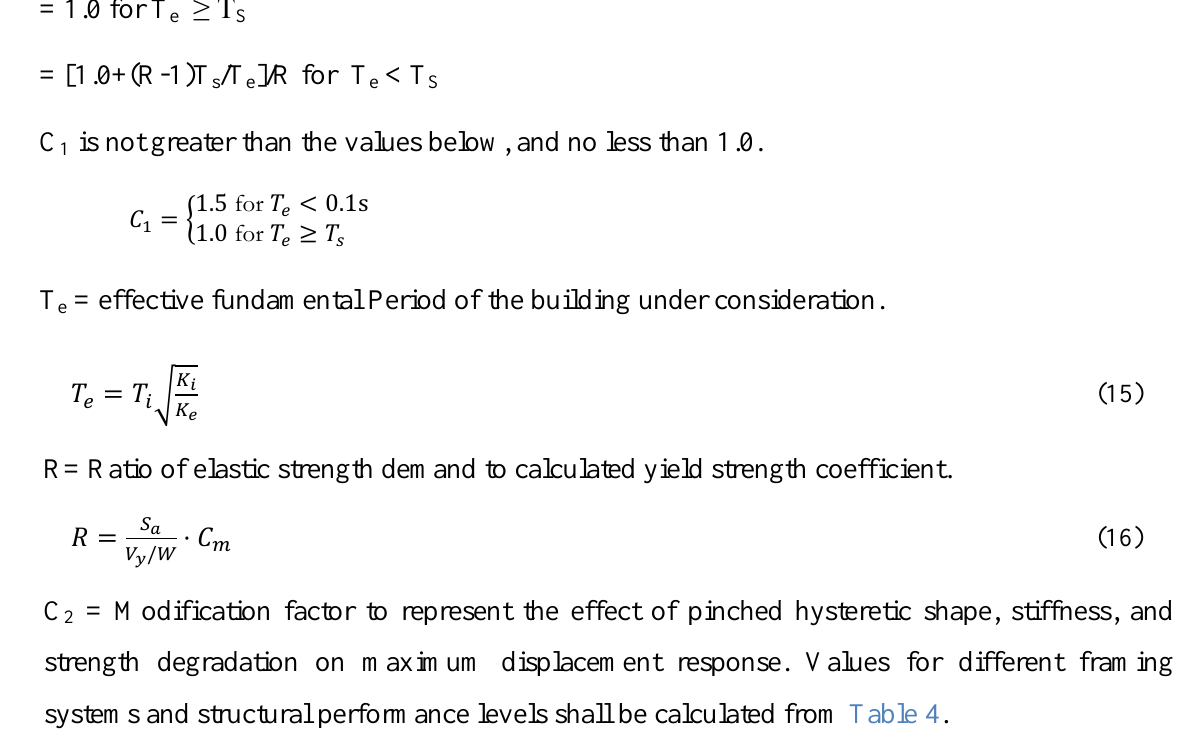
Table 4. Values for Modification Factor C